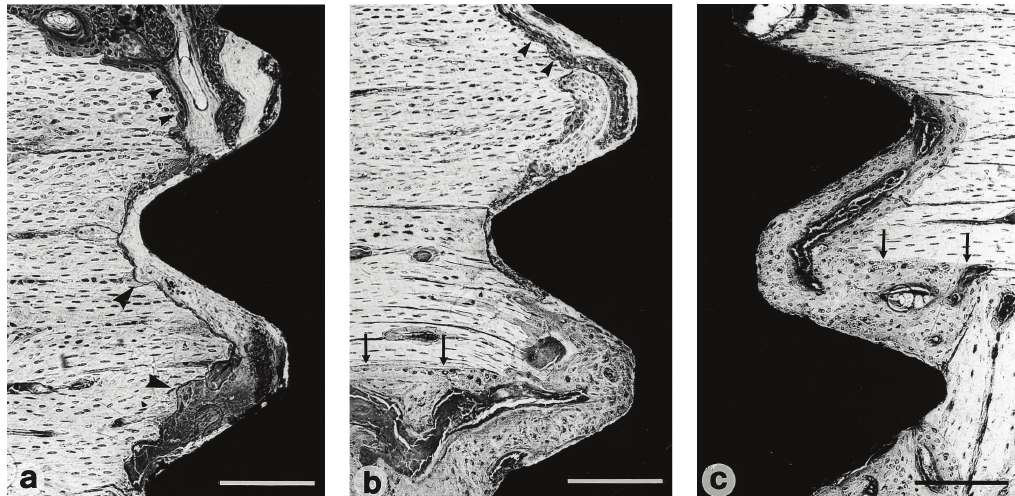
Figure 6: Three weeks after implantation. The cortical bone surface facing the implant surface is characterized by marked signs of resorption (large arrow heads) and the occurrence of new bone formation (small arrow heads). The border between the lamellar cortical bone and the newly formed bone is visible (arrows); (a) Machined (control) sample. Bar = 200 𝜇 m; (b) glow discharge cleaned and nitrided sample. Bar =